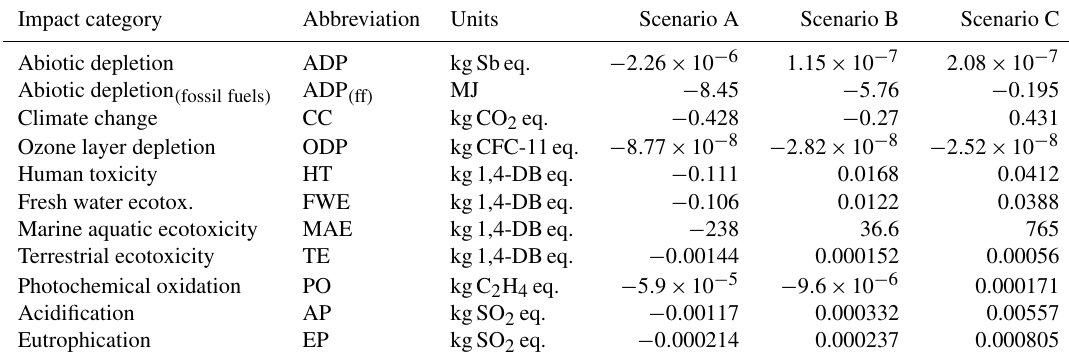
Table 3. Values for impact